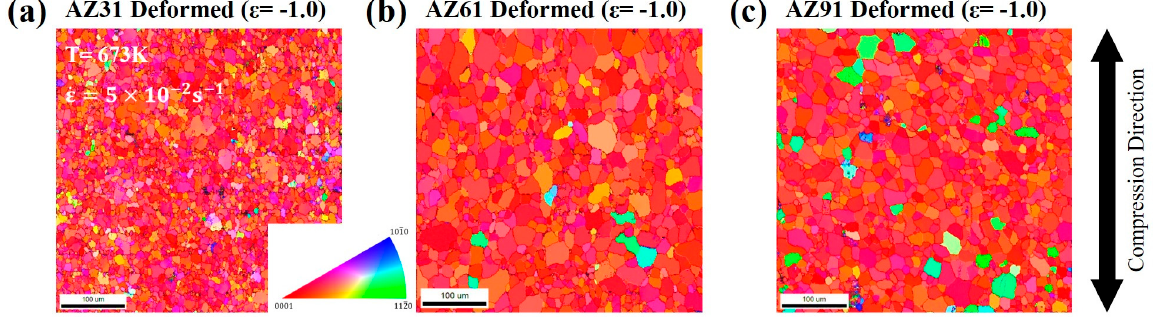
Figure 4. Grain structure map observed at the mid-plane section by EBSD measurement after deformation at a temperature of 673 K up to a strain of − 1.0 under a strain rate of 5.0 × 10 − 2 s − 1 . ( a – c ) AZ31, AZ61, and AZ91.